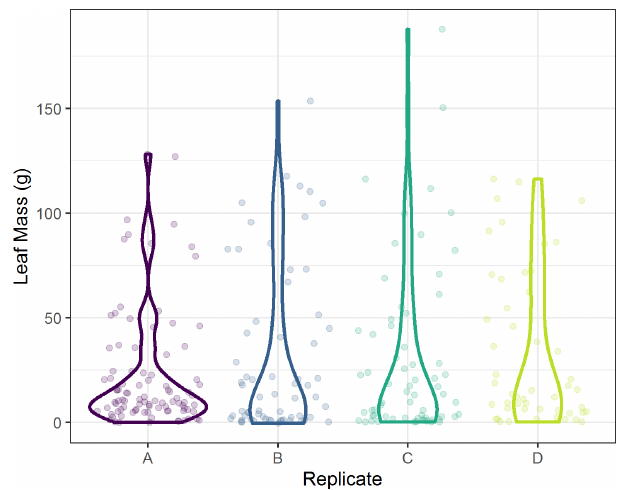
Figure 5. Distribution of litter mass values for 2018 by replicate. Lines represent distribution, while points are individual